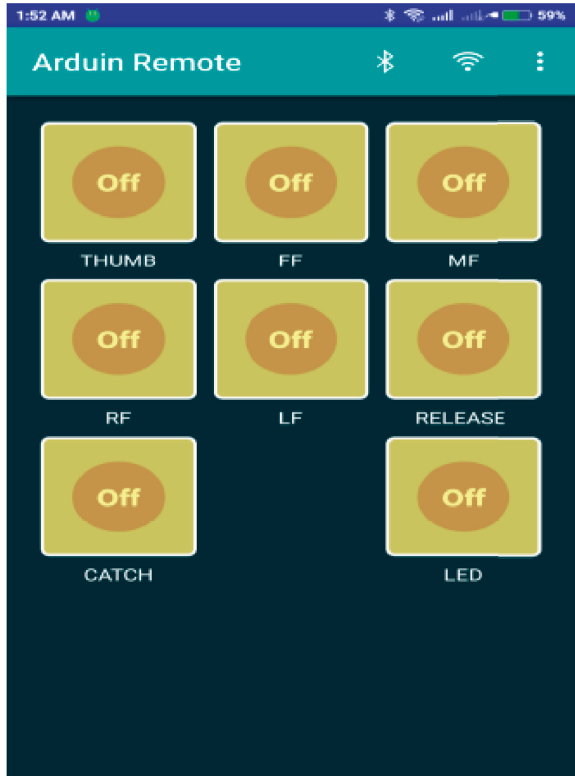
Figure 3: Mobile application.